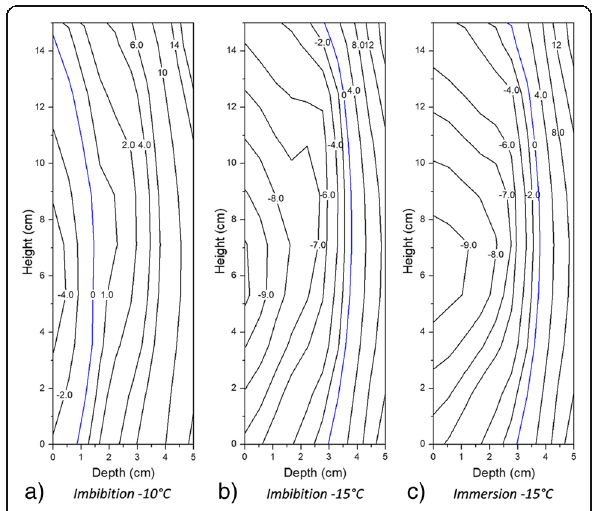
Fig. 6 Temperature mapping inside the sample after a capillary absorption and freezing at − 10 °C, b capillary absorption and freezing at − 15 °C, and c after immersion and freezing at − 15